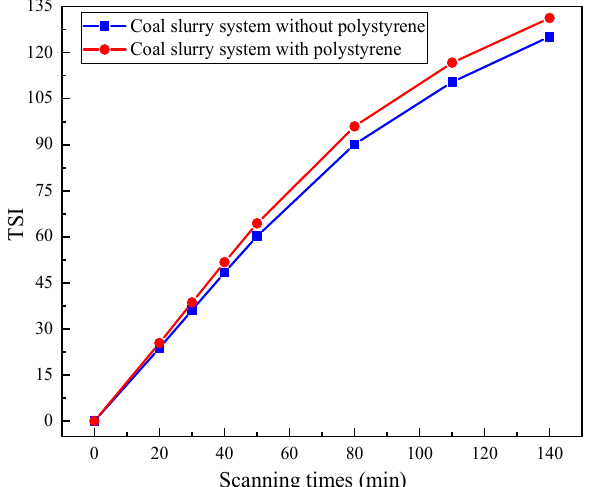
Figure 7. TSI variation of the coal slurry as a function of settling time with and without polystyrene particles.